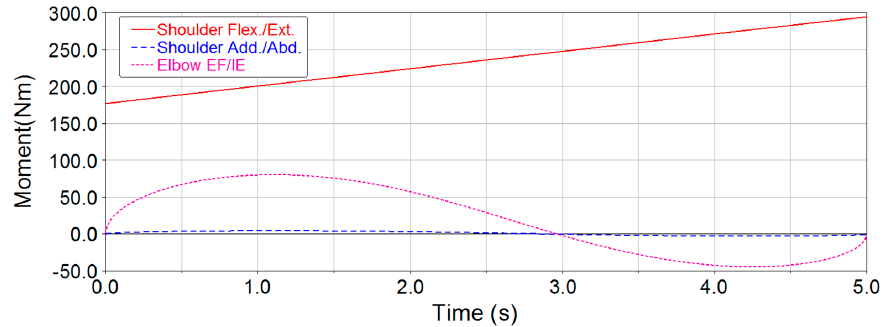
Figure 10. Joint torque curves of raising up for the 3 ‐ DOF exoskeleton.